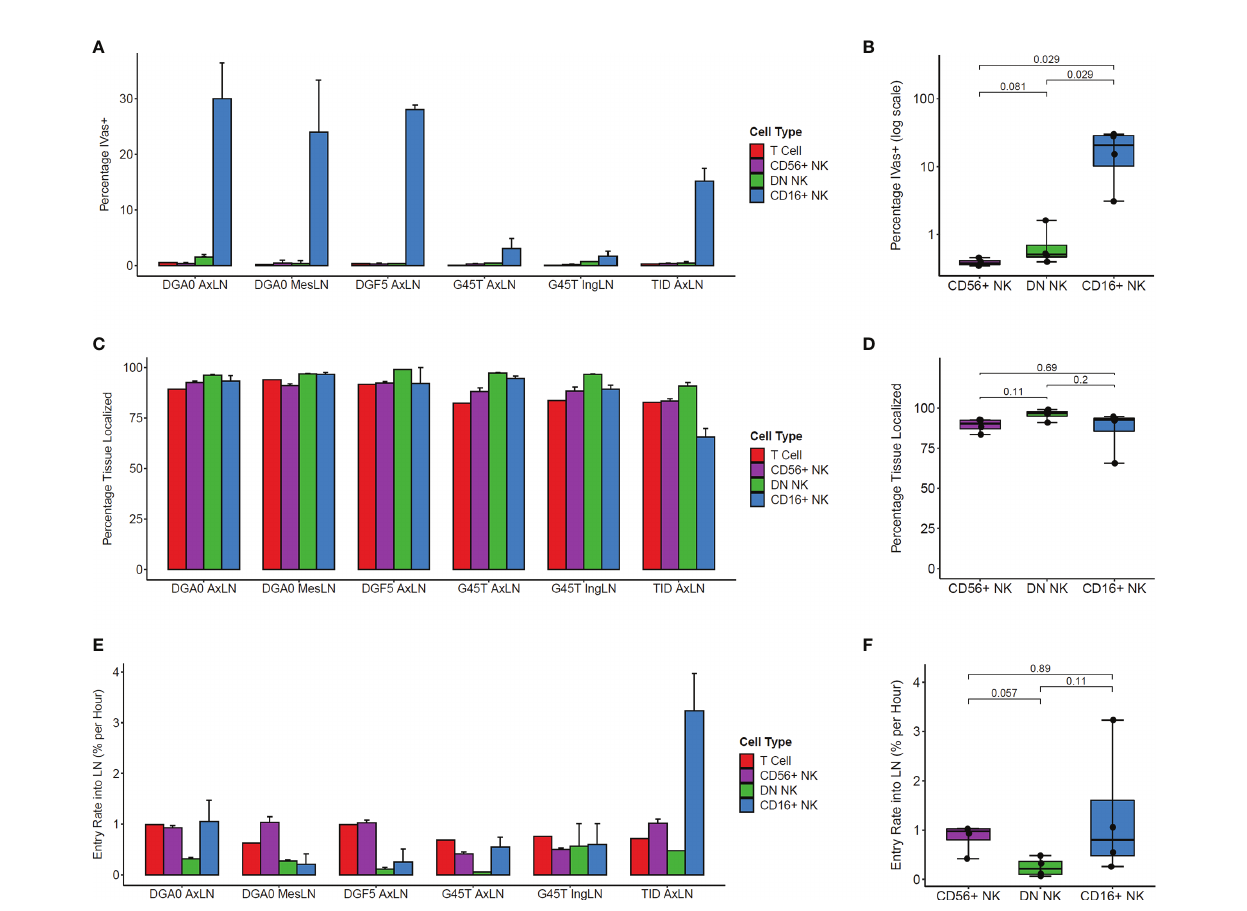
FIGURE 3 | Kinetics of NK cell traf fi cking into lymph nodes. (A) The percentage IVas+ cells in each cell subset from LN samples harvested from the four animals at time zero. IVas+/- refers to the SIVS antibody given 5 minutes prior to tissue harvest. (B) The mean percentage IVas+ cells for each NK cell subset within the AxLN sample for each animal was compared (n = 4 for each subset). For all boxplots, each dot shows the mean from one animal ’ s AxLN sample. The box shows interquartile range and the black line shows the median value for each NK cell subset. The whiskers extend to the furthest data point, and p-values shown were computed using a Wilcoxon test between each NK subset. (C) The percentage of IVas- cells for each cell subset which are “ Tissue Localized ” (negative for all SIVS antibodies given up to 48hr-G45T and TID or 6hrs-DGF5 and DGA0 before tissue harvest). (D) The Tissue Localized fraction for each AxLN sample in Panel (C) was compared using a Wilcoxon test (n = 4 for each subset). (E) The percentage of IVas- cells which are positive for the SIVS 6hr antibody for each subset divided by 6 hours to give an entry rate into the lymph node for each sample. (F) The mean entry rate for each AxLN sample is taken from panel (E) and compared between subsets using a Wilcoxon test (n = 4 for each subset). AxLN, Axillary Lymph Node; MesLN, Mesenteric Lymph Node; IngLN, Inguinal Lymph